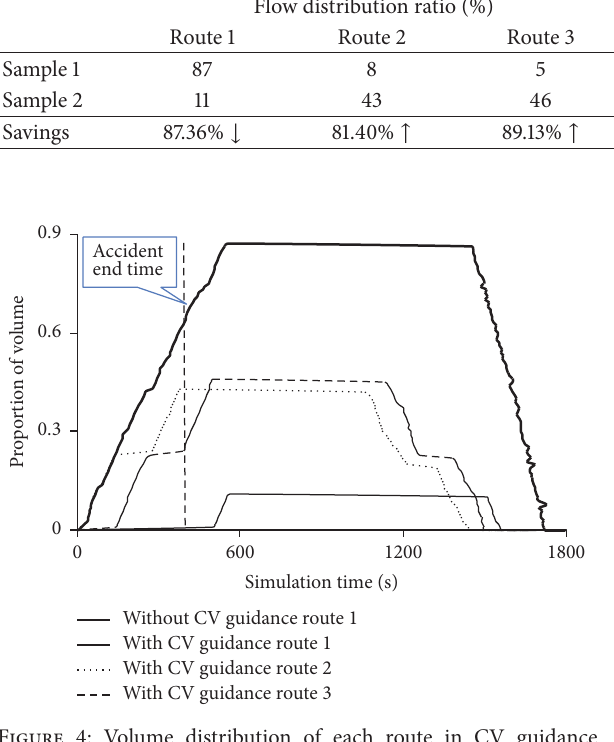
Figure 4: Volume distribution of each route in CV guidance environment.